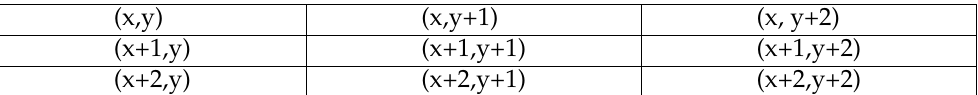
Table 1. Change of Coordinates around the Robot as a Result of